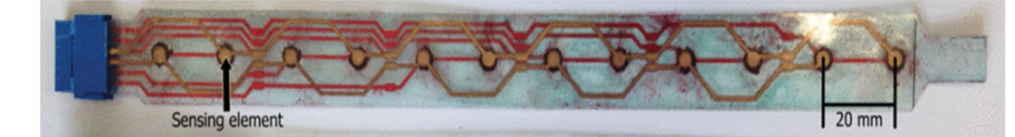
Figure 12. Completed sensor strip featuring twelve sensitive elements, as reported in [51], Copyright 2020